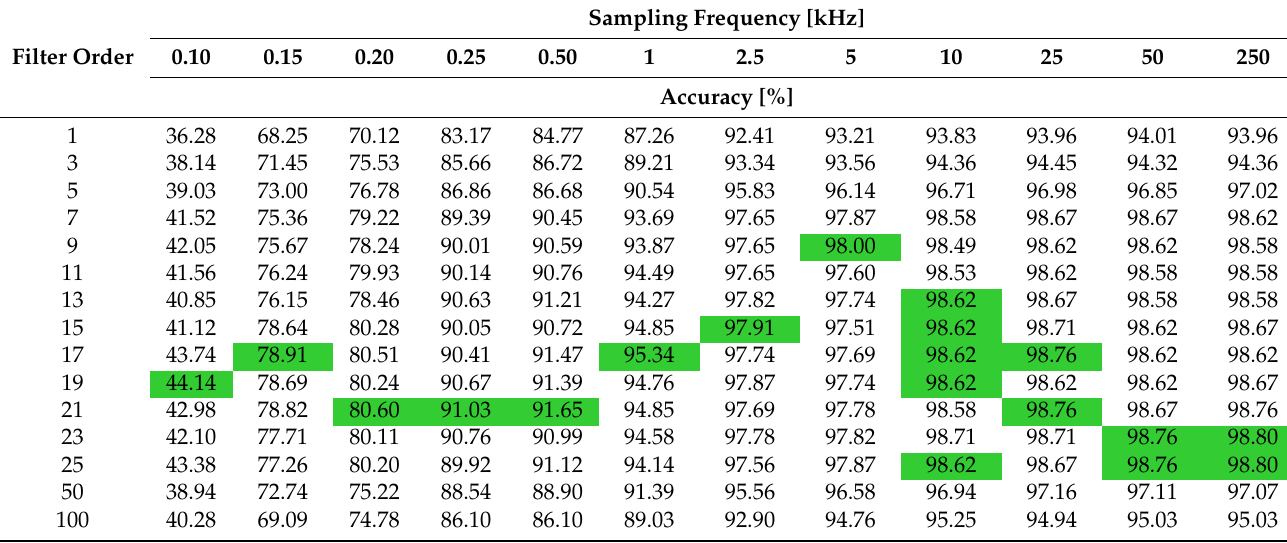
Table 5. Event identification accuracy using the dictionary method.